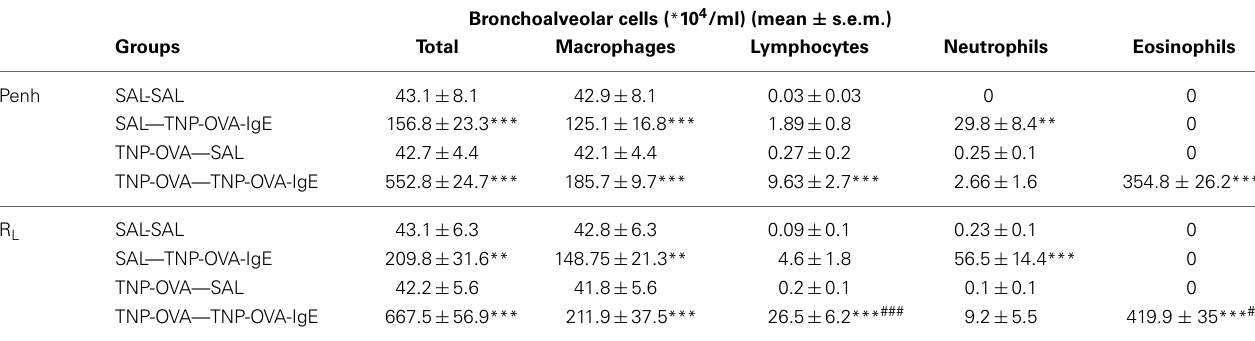
Table 4 | Total and differential cell counts in broncho-alveolar lavage fluid in the severe airway inflammation model.